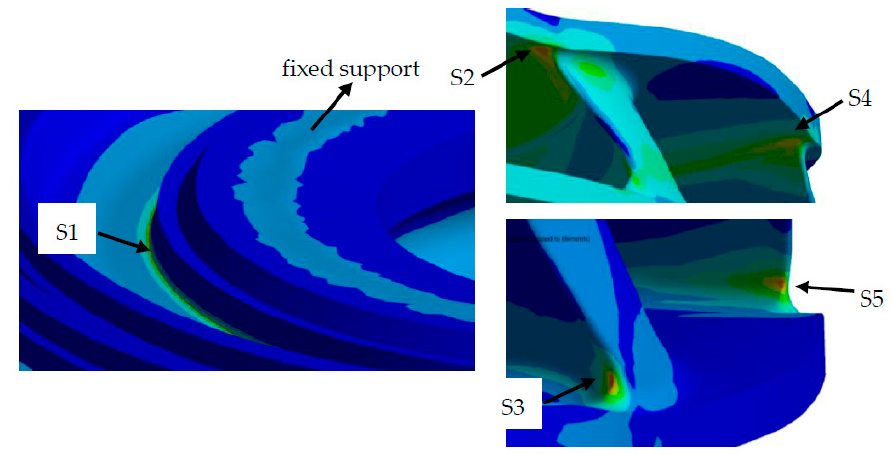
Figure 11. Selected nodes in high stress regions. The mean stress of S1–S5 during start-up process is plotted in Figure 12. In order to make the influence of hydraulic loads explicit, the FEM analysis considering only hydraulic loads was performed and the mean stress is also shown in Figure 12. The stress at rated working condition was calculated, and marked as grey dotted